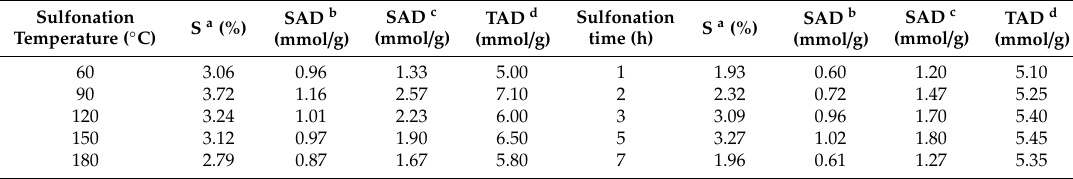
Figure 1. E ff ect of sulfonation conditions on the acetylation of glycerol with acetic acid catalyzed by the synthesized catalyst at 120 ◦ C, a G / AA mole ratio of 1:6, a catalyst load of 0.5 g (10% G), and a reaction time of 3 h. ( a ) Sulfonation temperature (sulfonation time of 5 h) and ( b ) sulfonation time (sulfonation temperature of 90 ◦ C). Table 1. Sulfur content and acid density of catalyst prepared at various sulfonation temperatures (5 h) and times (90 ◦